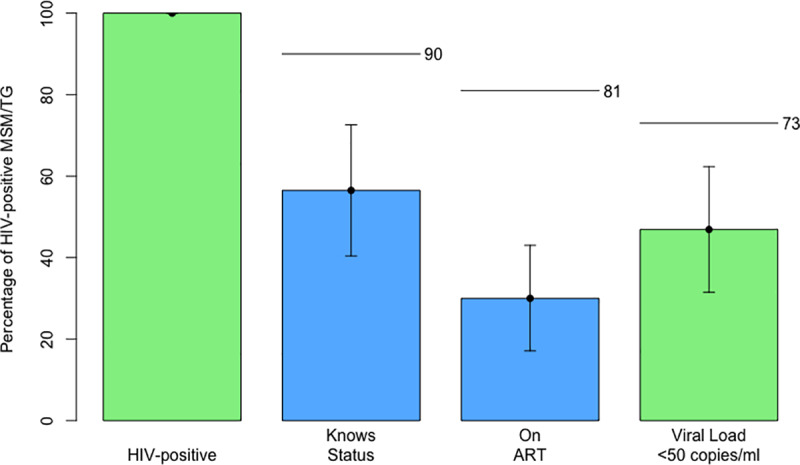
The HIV care cascade among MSM/TG in Johannesburg, n = 300.